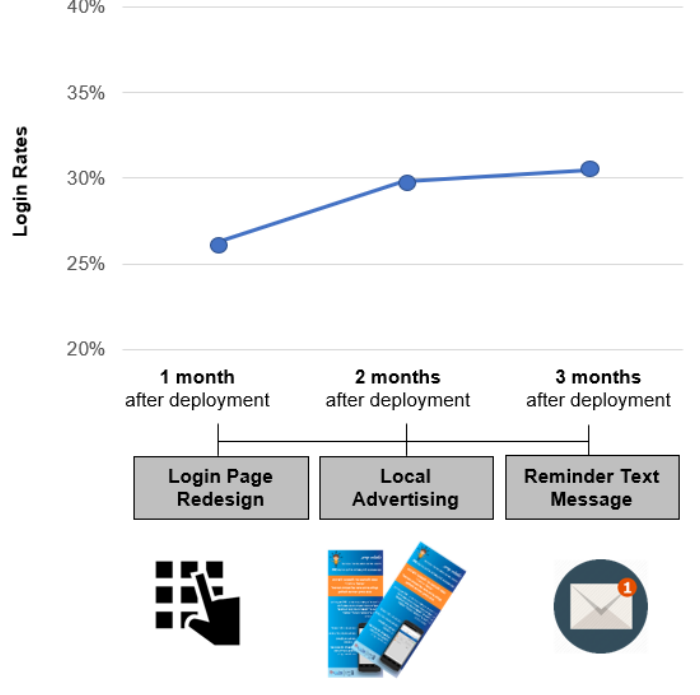
Figure 6. Influence of design modifications on myED login rates.